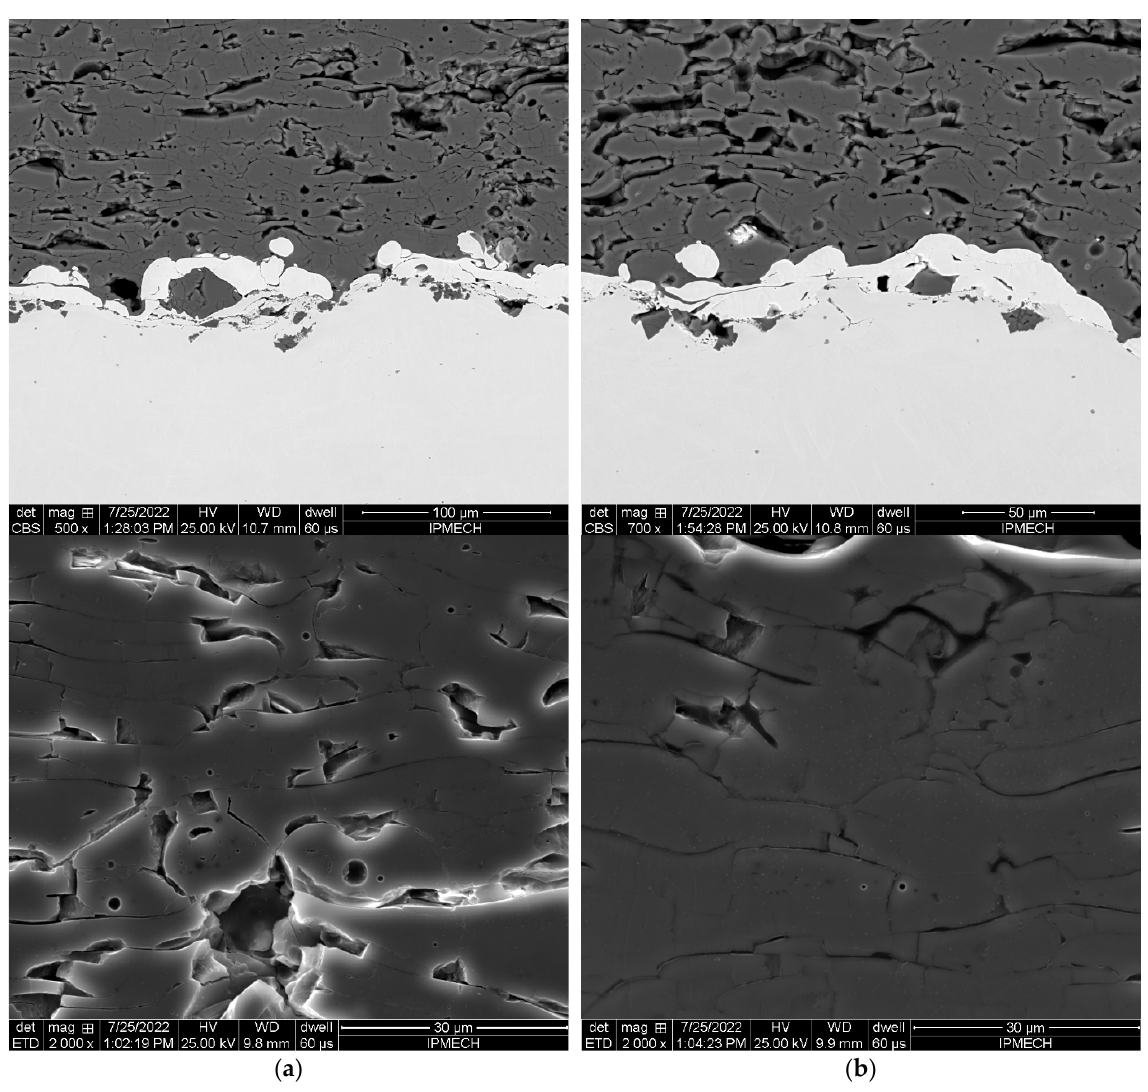
Figure 5. Cross-section SEM images of microstructures of the coating: ( a ) Al 2 O 3 ; ( b ) MgAl 2 O 4 . For spray parameters, refer to Table 2.